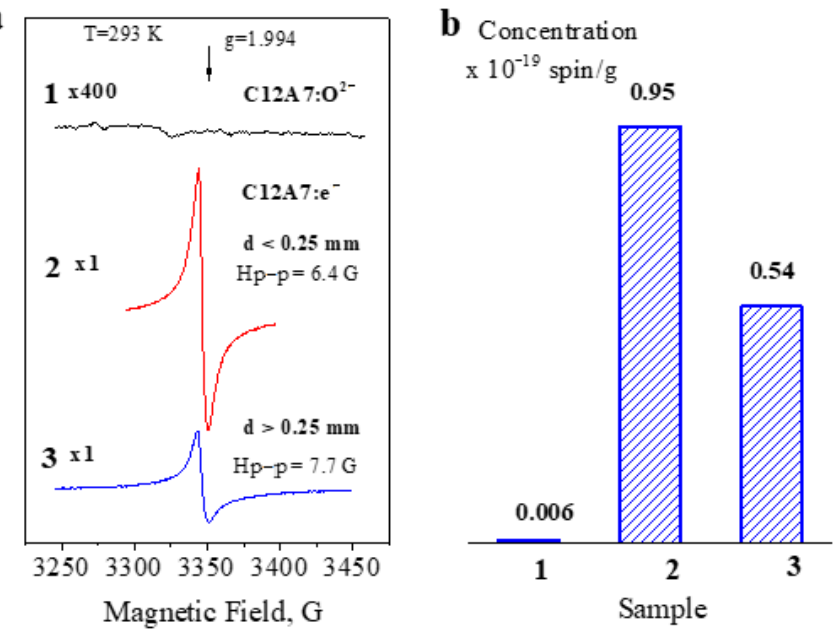
Figure 4. A: EPR spectra of sample C12A7:O 2 − (1) and sample C12A7:e − after its grinding in an agate mortar with separation of fractions d < 0.25 mm (2) and d>0.25 mm (3). B: Concentration of para-